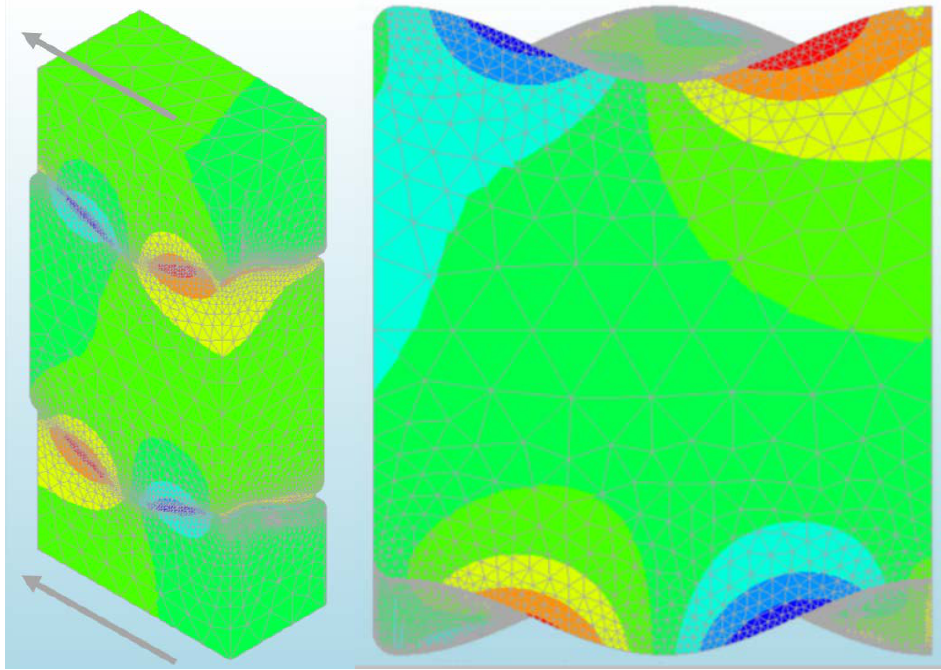
Fig. 11: Numerical set up and results for Christensen’s failure criterion value of one of the tested